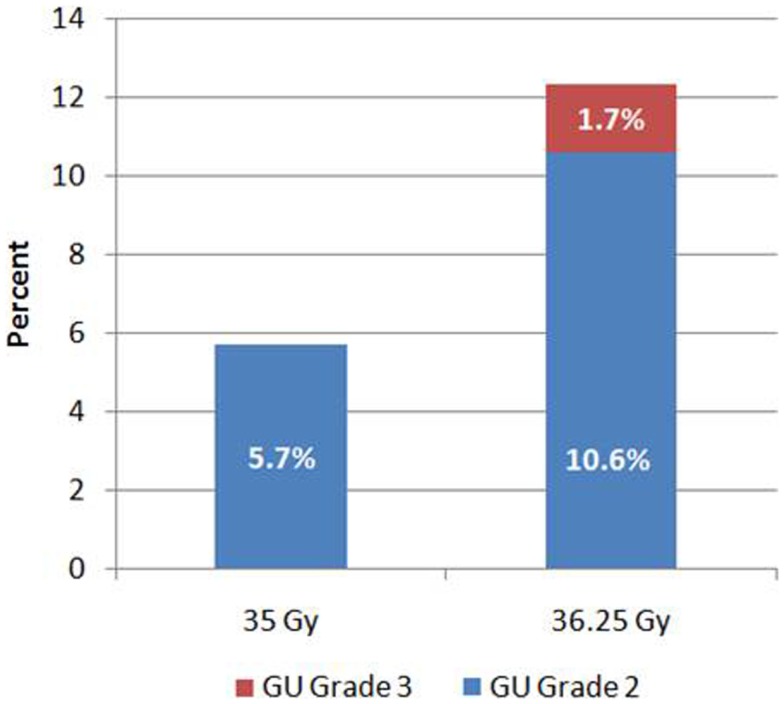
Genitourinary toxicity by dose.